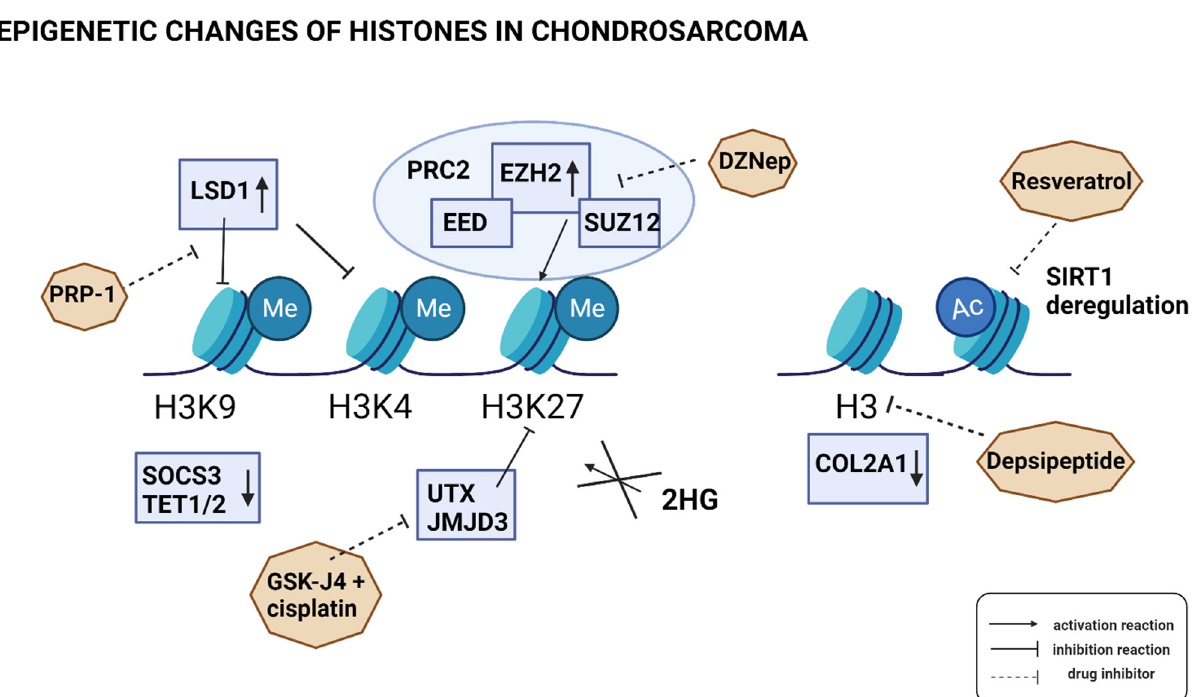
Figure 1. Epigenetic changes to histones in chondrosarcoma (CS). The mechanism of histone modification is still not fully understood; however, some proteins were observed to play a role in this process in CS. The methylation of histone H3 lysine K9 (H3H9), histone H3 lysine K4 (H3K4), and histone H3 lysine K27 (H3K27) appears to be independent of δ -2-hydroxyglutarate (2HG); however, the methylation of H3K27 is related to increased expression of enhancer of zeste homolog 2 (EZH2)—a part of the Polycomb Repressive Complex 2 (PRC2), together with Embryonic Ectoderm Development (EED) and Suppressor of Zeste 12 Protein Homolog (SUZ12). This process can be inhibited by 3-Deazaneplanocin A (DZNep). On the other hand, H3K4 and H3K9 demethylation (which leads to inactivation of the suppressor of cytokine signaling 3 ( SOCS3 ) and ten-eleven translocation methylcytosine dioxygenase 1 and 2 ( TET1/2 )), is caused by the expression of histone lysine-specific demethylase 1 (LSD1). This can be inhibited by proline-rich polypeptide-1 (PRP-1). Lysine-specific demethylase 6A (KDM6A, UTX) and lysine demethylase 6B (KDM6B, JMJD3) decrease H3K27 methylation, which can be blocked by the GSK-J4 inhibitor in combination with cisplatin. Sirtuin1 (SIRT1) deacetylase deregulation can be blocked by resveratrol, while decreased acetylation of H3 and collagen alpha-1(II) chain ( COL2A1 ) expression can be reversed by depsipeptide.